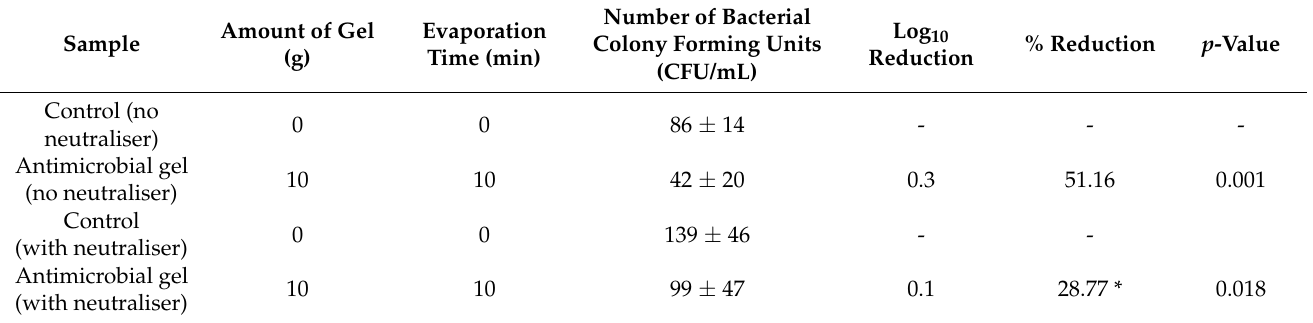
Figure 3. Numbers of E. coli K12 recovered from different aerosol sizes with or without neutralisation of the vapours of essential oils for 10 min. The gel significantly reduced the viability of bacteria in aerosols sizes 3.30, 2.10 and 1.10 µm when essential oils were non-neutralised during bacterial growth compared to the untreated control (*, p = 0.001). Data points represent the mean ( ± 95% confidence interval) of three independent experiments. CFU = colony forming units. Table 3. The ability of vapours of essential oils to reduce the numbers of aerosolised E. coli K12.